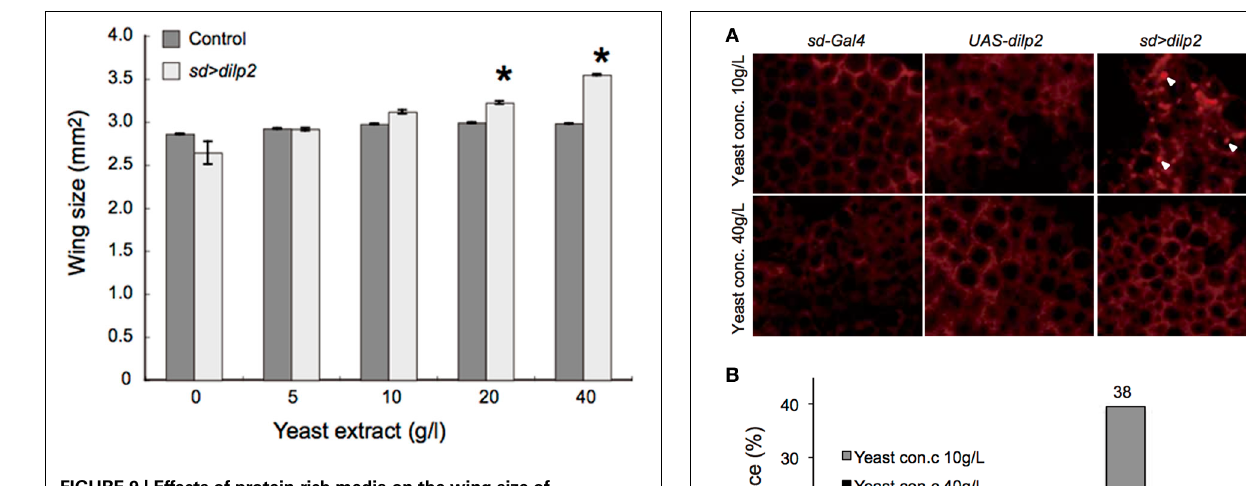
FIGURE 9 | Effects of protein-rich media on the wing size of dilp2 -overexpressing flies. dilp2 -overexpressing flies ( sd > dilp2 ) were reared on media supplemented with various concentrations of yeast extract and their wing sizes were compared with those of the internal control flies. Mean wing area was positively correlated with the concentration of yeast extract in the media. Student t -test was performed to analyze statistical significance. ∗ p < 0 . 05.